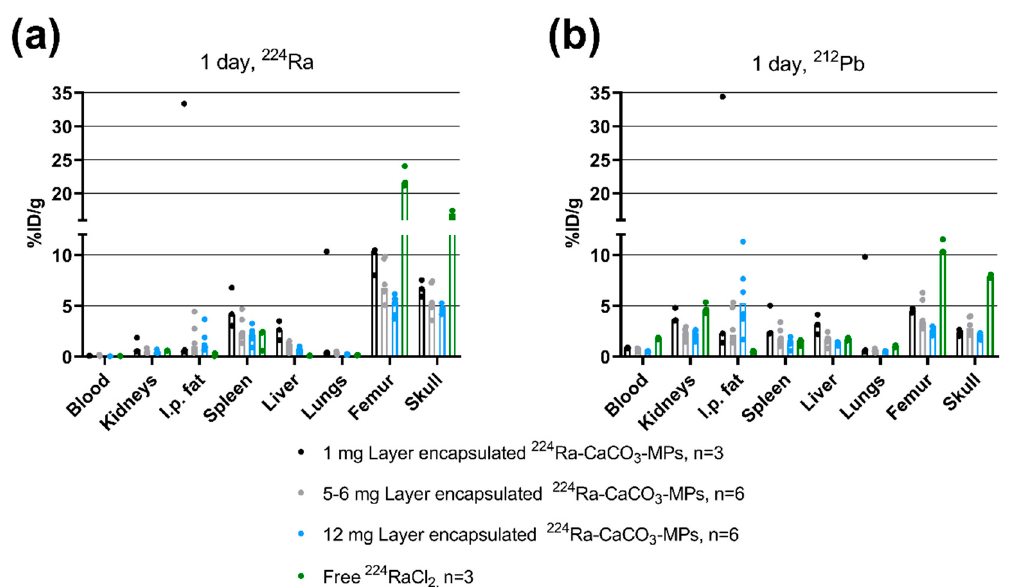
Figure 5. Biodistribution of layer-encapsulated 224 Ra surface-labeled CaCO 3 microparticles one day after i.p. injection. Bars represent the median and symbols represent individual animals. Animals that were treated with equal or near-equal mass doses have been pooled into one group. ( a ) Percentage injected dose per gram tissue of 224 Ra. ( b ) Percentage injected dose per gram tissue of 212 Pb from the same samples as in ( a ). There is missing data for 224 Ra and 212 Pb for one skull in the 224 RaCl 2 group and for 212 Pb for one blood sample in the 12 mg group due to instrument errors.